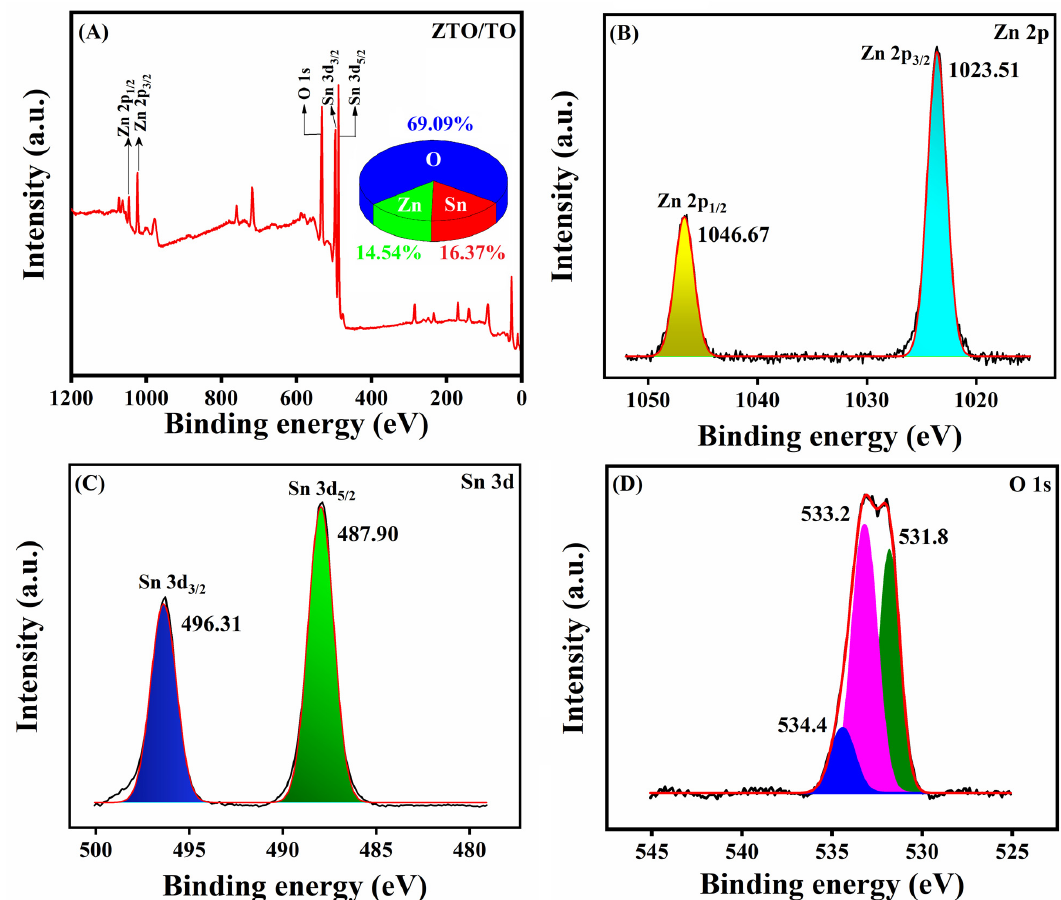
Figure 4. ( A ) XPS survey spectra of ZTO/TO MPs and high-resolution XPS spectra of ( B ) Zn 2p ( C ) Sn 3d, and ( D ) O 1s.